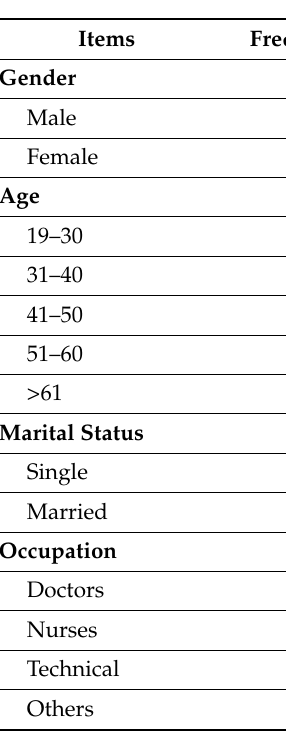
Table 1. Demographic